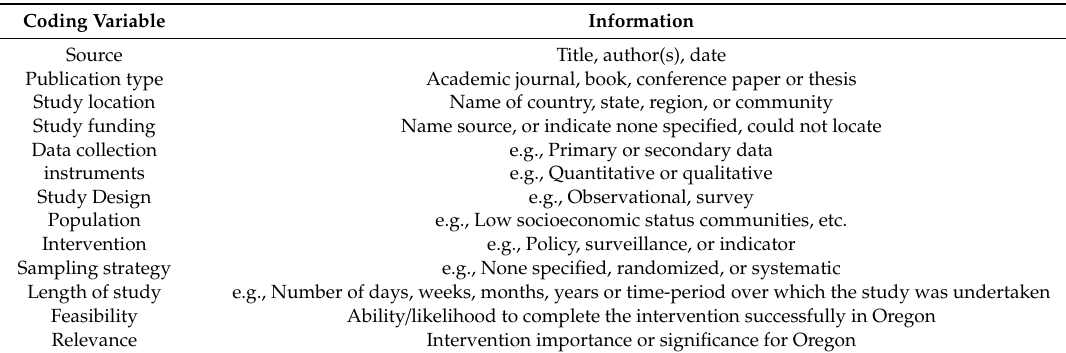
Table 1. Study Coding